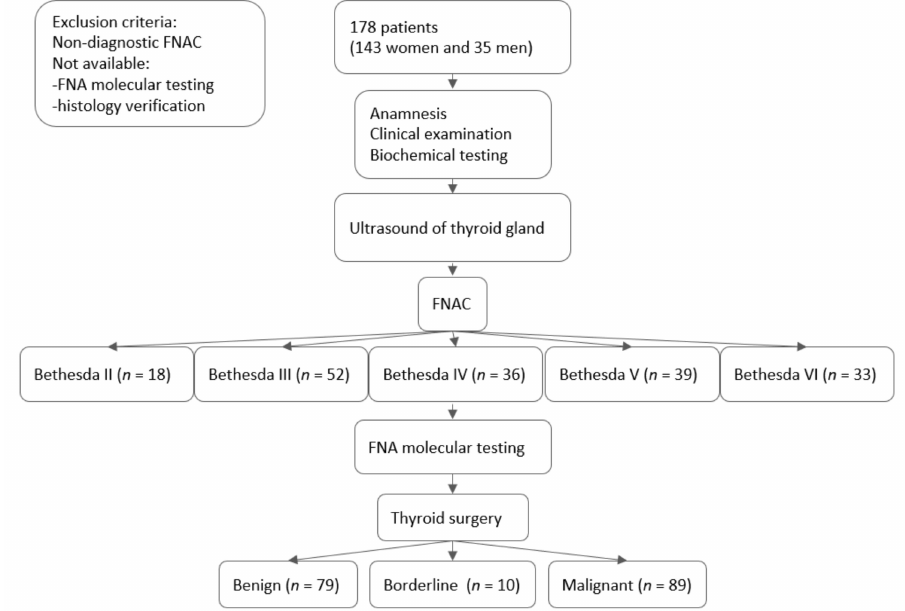
Figure 1. Flowchart of the